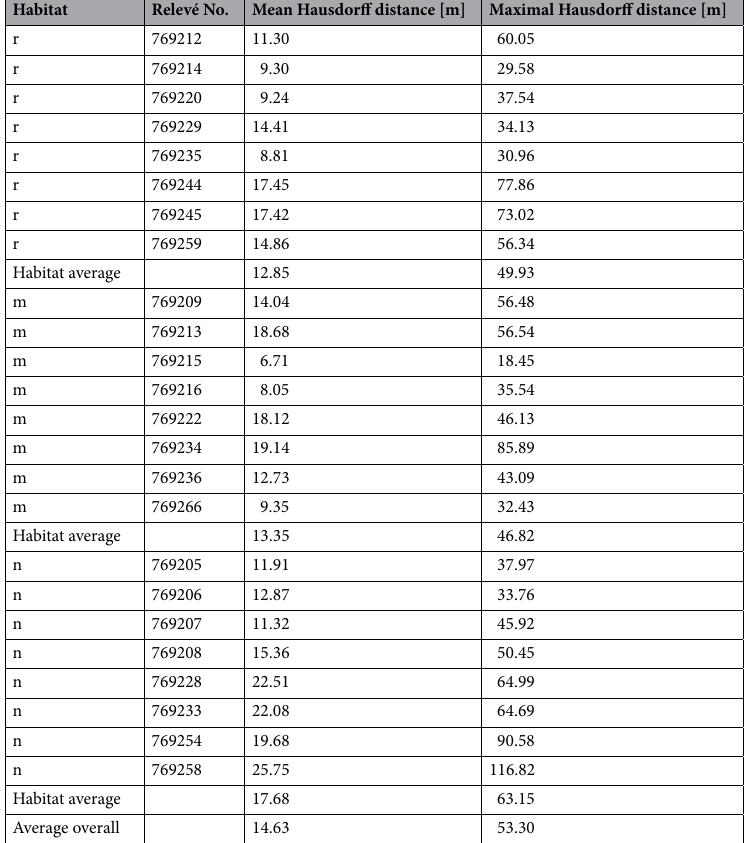
Table 3. Results of automatic segmentation and GPS tracks compared by the Hausdorff distance (values given in meters). Abbreviations to habitats: n – planted spruce forest, m – 9130 – Asperulo-Fagetum beech forests, and r – 9180 – Tilio-Acerion forests of slopes, screes, and